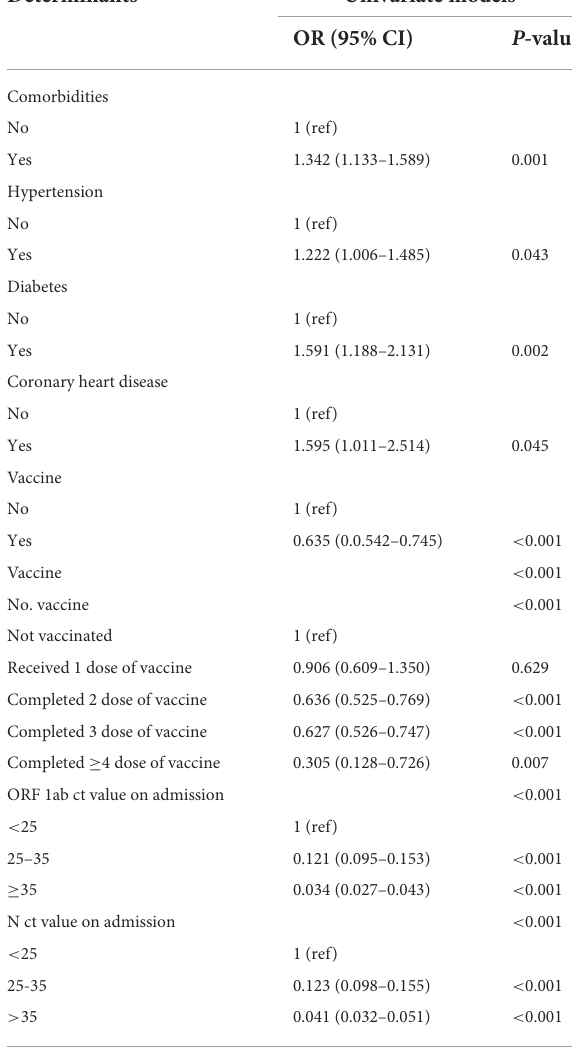
TABLE 2 Factors associated with persistently PCR-positive patients at univariate regression